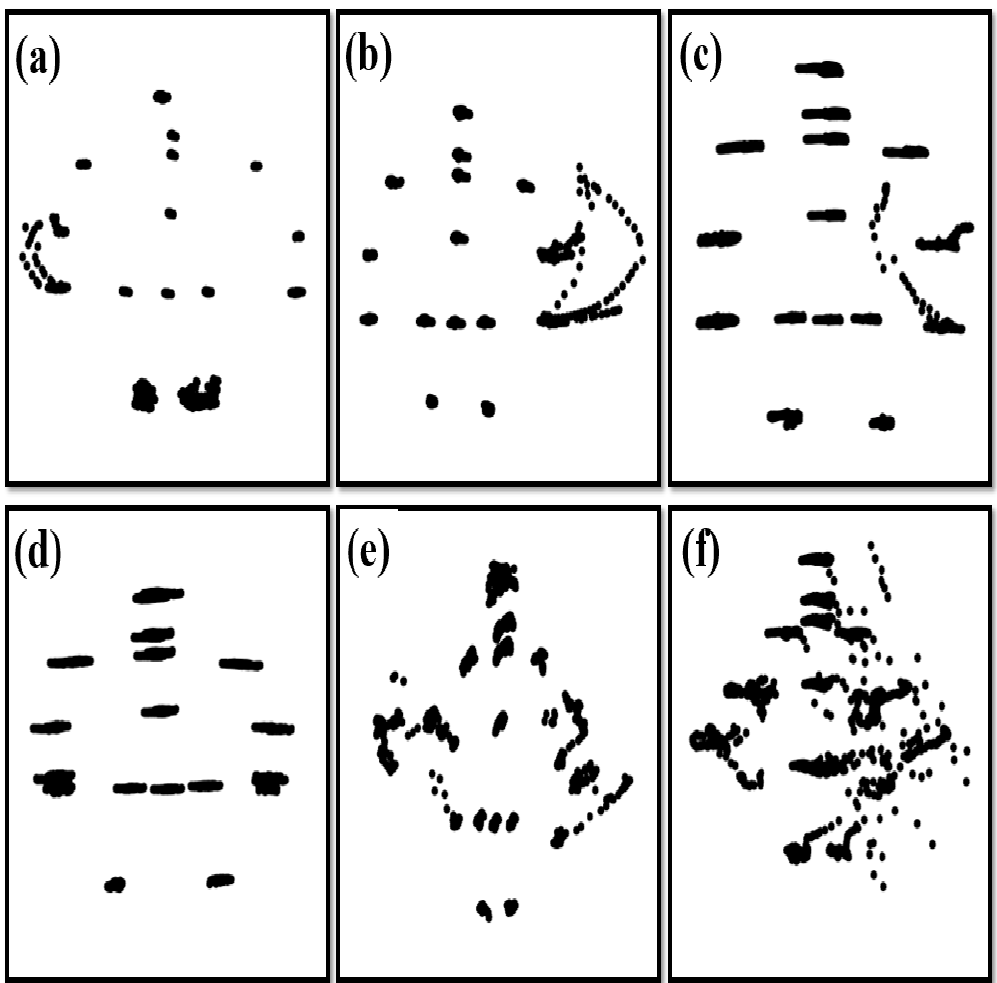
Figure 6. Abnormal patterns of postural control in several participants. ( a ) The forearm and knee joints exhibited slight tremors. ( b ) The forearm and hand joints exhibited obviously tremors. ( c ) The whole body shook horizontally and the left forearm shook more. ( d ) The whole body shook horizontally. ( e ) Symmetrical shaking of the wrists and lower limbs occurs on both sides. ( f ) Individual stands with whole-body asymmetrical shaking.